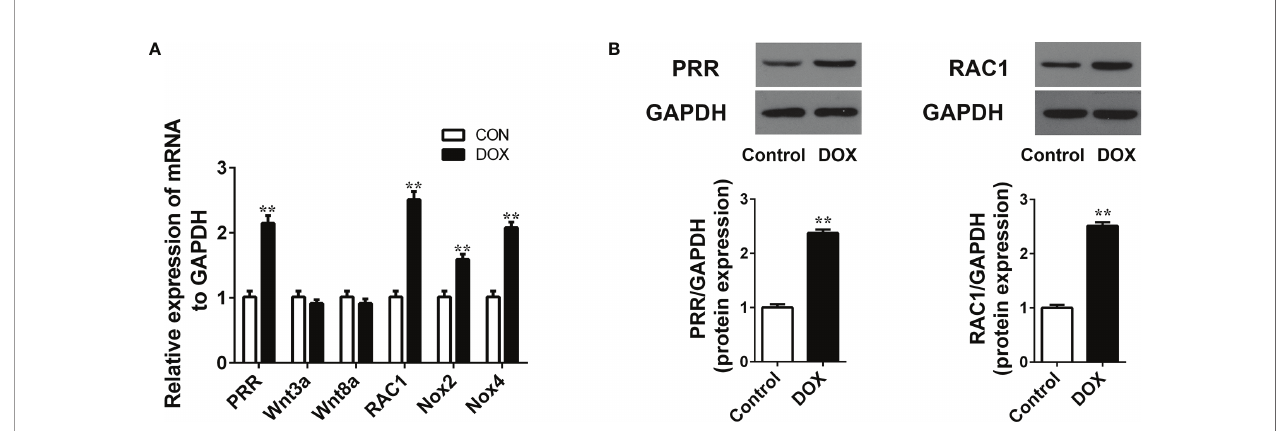
FIGURE 2 | Doxorubicin treatment increases the mRNA/protein expression of PRR and RAC1. (A) RT-qPCR assay to evaluate the mRNA levels of PRR, Wnt3A, Wnt8a, RAC1, NOX2 and NOX4 in heart tissues (n = 3). (B) Western blotting and statistical analysis of the (pro)renin receptor (PRR) protein expression(n = 3). Data are presented as the mean ± SEM. ** p < 0.01 vs